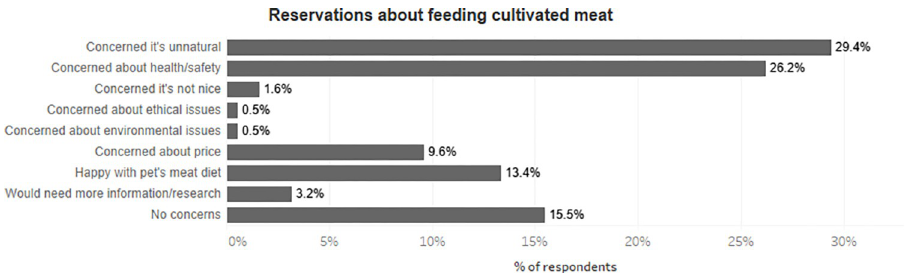
Fig 7. Reservations about feeding cultivated meat among those whose primary concern about removing meat from pet’s diet was that meat was ‘natural’ (N =